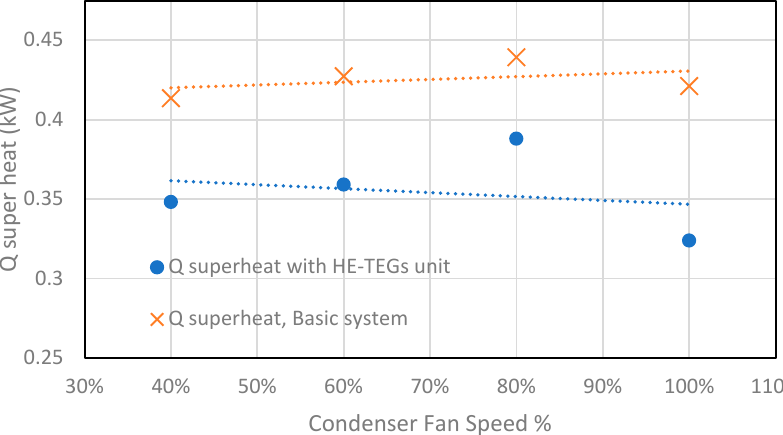
Figure 8. Variation of Q-superheat with condenser fan speed with and without HE-TEGs unit.